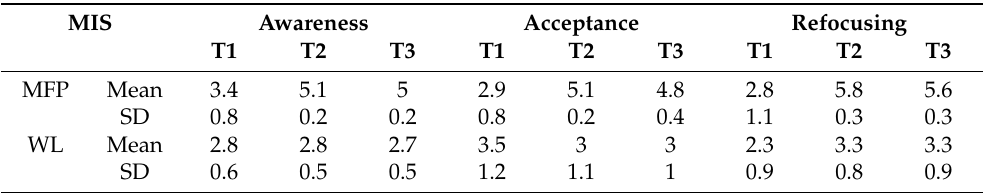
Table 2. Average and standard deviation of MIS scores before (T1), after the 6-weekintervention (T2), and 6 weeks later (T3) for the experimental (MFP) and wait list (WL) groups.